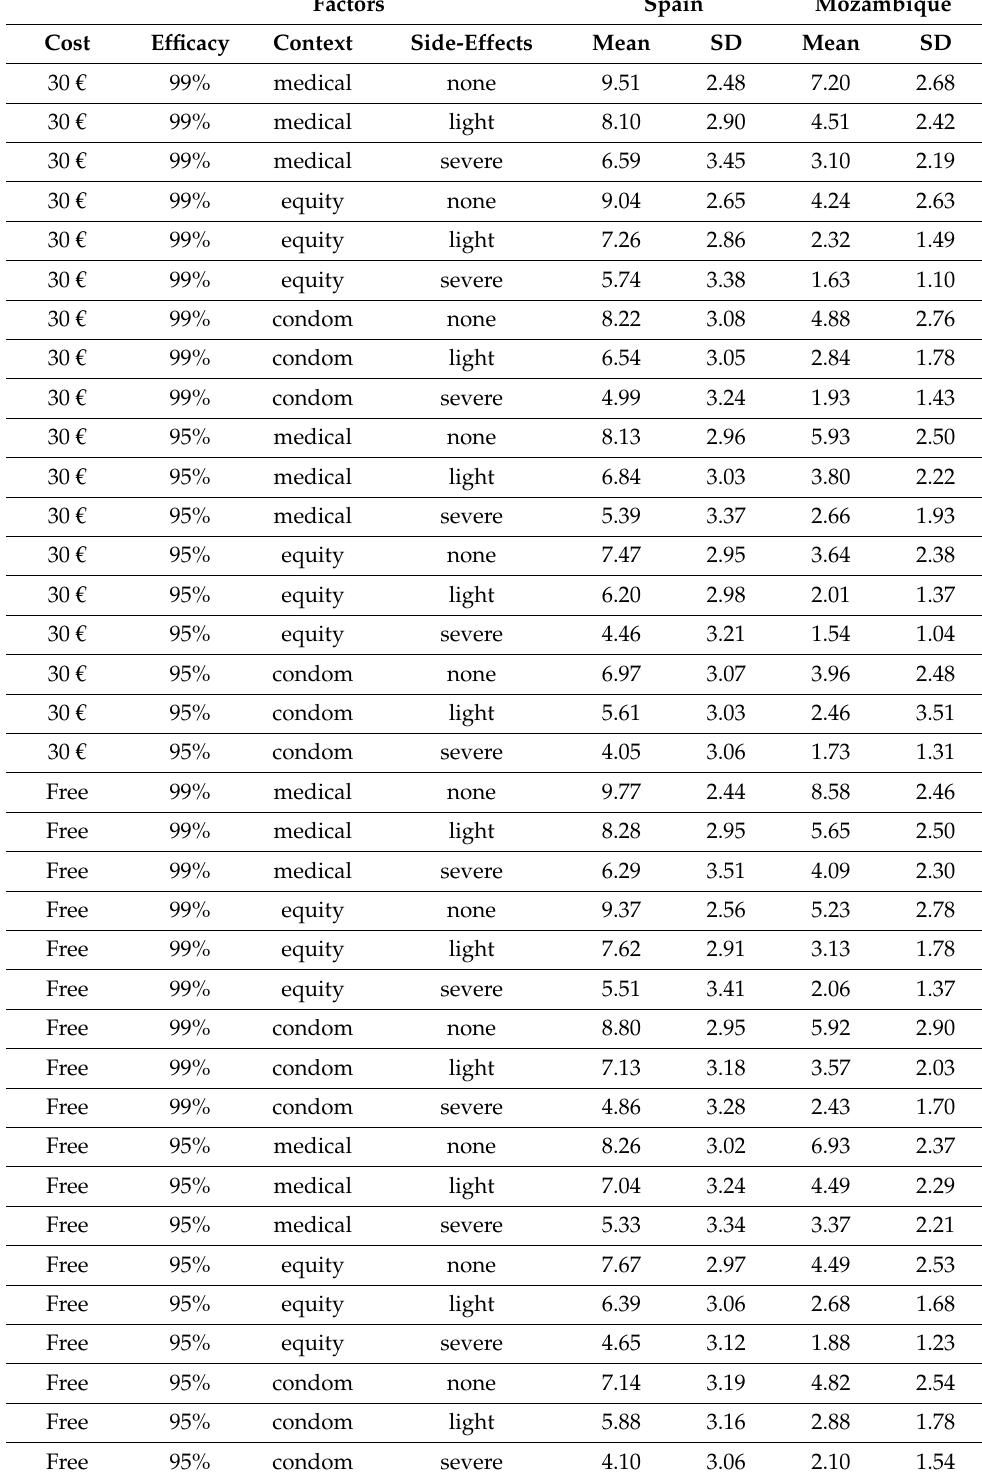
Table 3. Spain-Mozambique Comparison: Means and Standard Deviations Observed for Each Level of Each